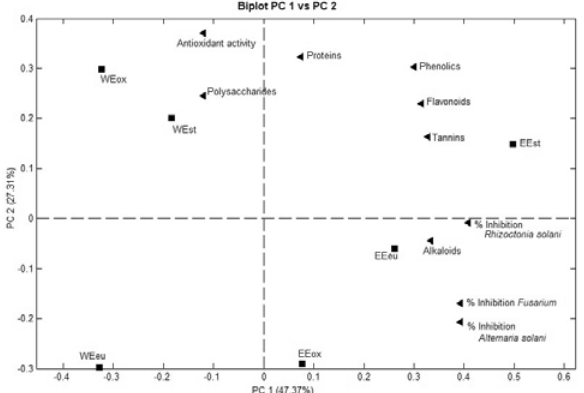
Figure 8. Main biplot (loadings and scores) obtained from prin- cipal component analysis for data from ethanol and water extract evaluations, along principal components 1 (PC1) and 2 (PC2). WE and EE indicate, respectively, values for water and ethanol extracts. ox: Oxalis barrelieri L., st: Stachytarpheta cayennensis L., and eu: Euphorbia hirta L. Symbol ■ depicts the different extracts (scores), whereas ◄ represents the bioactivities and biochemical properties of the extracts